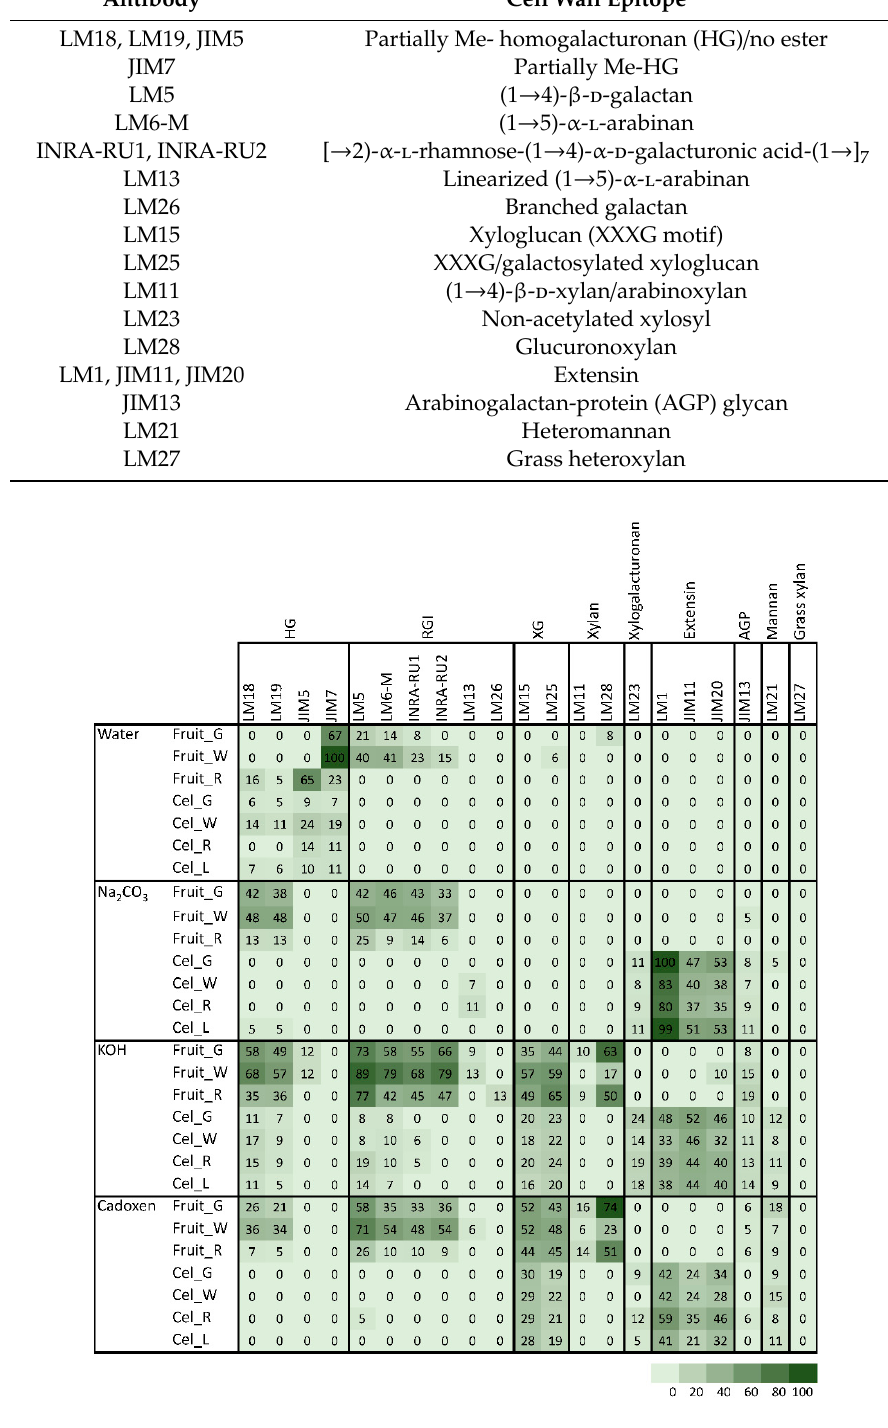
Figure 6. Heat map showing the relative abundance of cell wall epitopes recognized by di ff erent mAbs in cell wall fractions extracted from strawberry fruits and cell cultures obtained from leaf and fruit receptacle at di ff erent developmental stages. A value of 100 was assigned to the highest mean spot signal, and all other signals were adjusted accordingly. Fruit_G: unripe-green fruit; Fruit_W: white fruit; Fruit_R: mature-red fruit; Cel_G: callus from green fruit; Cel_W: callus from white fruit; Cel_R: callus from mature-red fruit; Cel_L: callus from